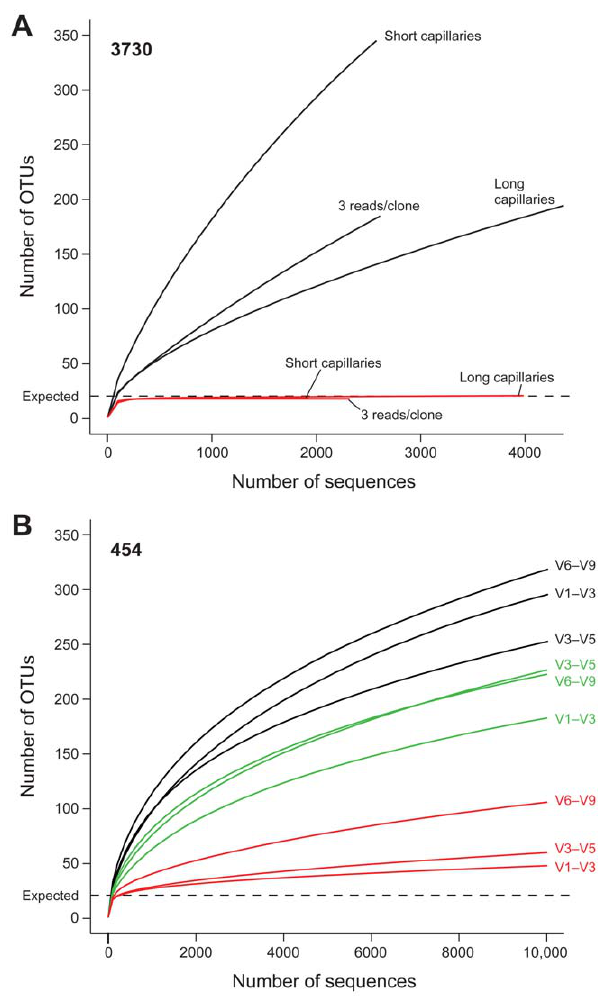
Table S1 Read Counts for 454 data in Figures 2 & 3. Table S2 Read Counts for 3730 data in Figures 2 & 3. Table S3 Broad Barcoded Oligos (V1–V3). Table S4 Broad Barcoded Oligos (V3–V5). Table S5 Broad Barcoded Oligos (V6–V9). Figure 11. Improved estimation of community diversity after